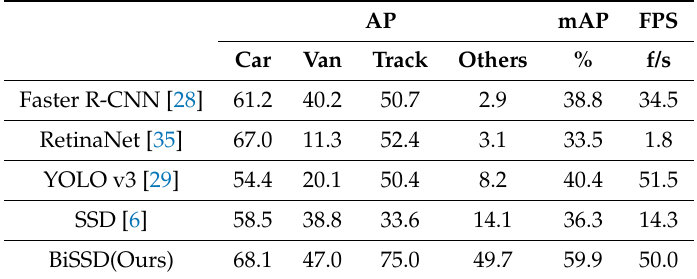
Table 2. Experimental results of each model on UA-DETRAC data set.